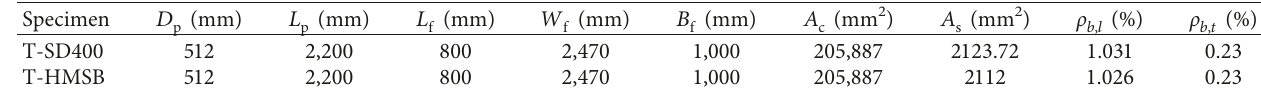
Figure 4: Test specimen layout: (a) dimensions and (b) reinforcement arrangement. Table 1: Dimensions of test